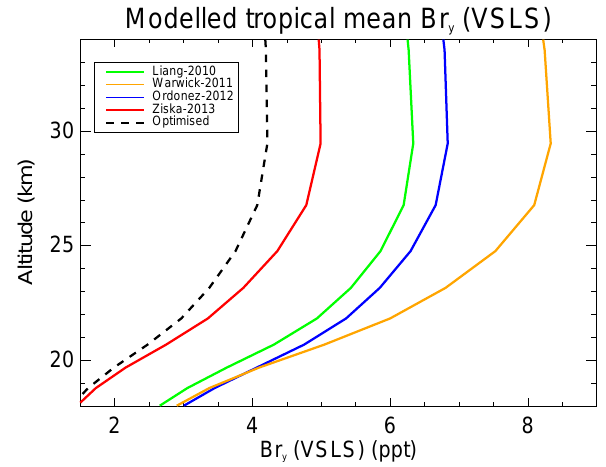
Fig. 13. Modelled 2011 tropical ( ± 30 ◦ ) mean profile of total in- organic bromine (ppt) from CHBr 3 , CH 2 Br 2 , CHBr 2 Cl, CH 2 BrCl and CHBrCl 2 (Br VSLS y ) in the stratosphere. Profiles are shown for CTM runs S Liang , S Warwick , S Ordonez , and S Ziska . An optimised es- timate, calculated by combining CHBr 3 from S Ziska and CH 2 Br 2 from S Liang , is also